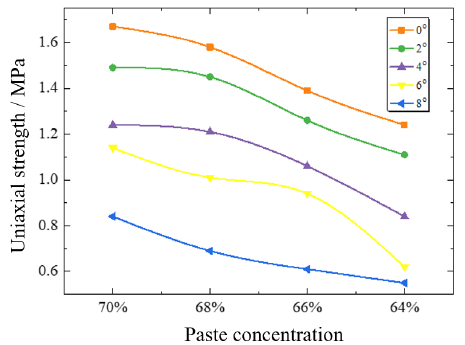
Figure 14. Strength of backfill under the influence of accumulation Angle.